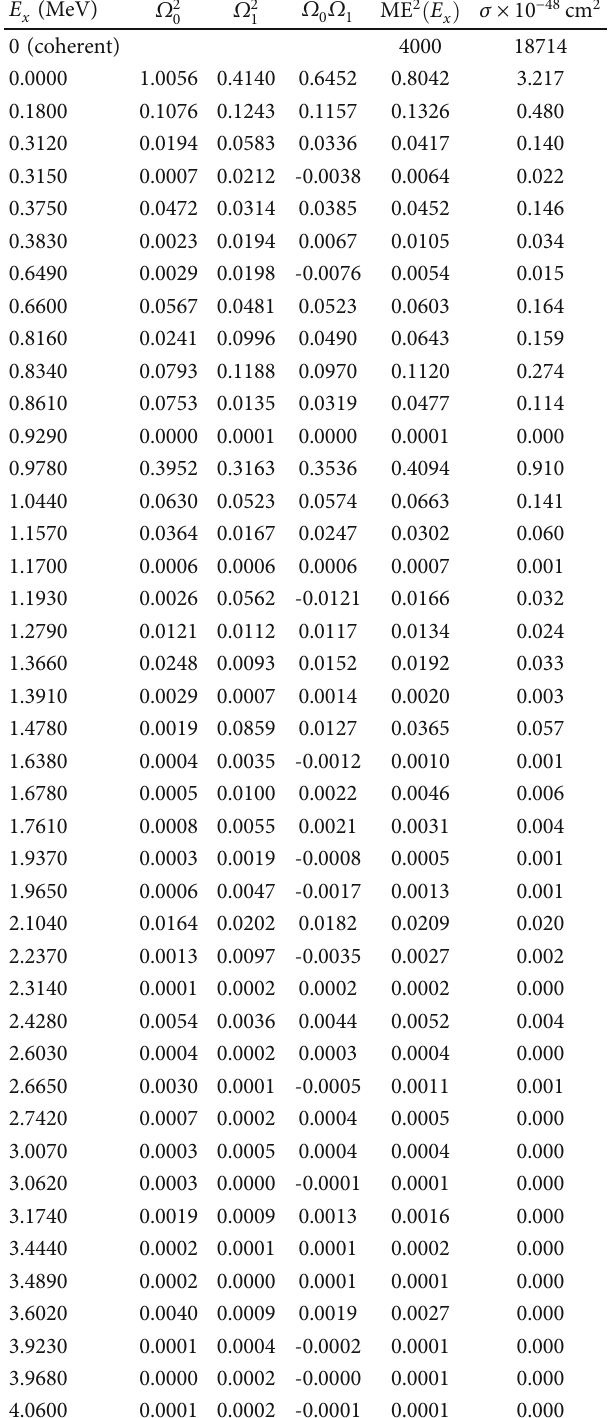
Table 1: Isoscalar and isovector spin-dependent matrix elements of 127 I from ground ( 5/2 + ) to excited states up to to the axion energy gs of 5.5MeV, which are relevant for axion photoproduction. We also Þ , including that include the total nuclear matrix elements ME 2 ð E x of the spin-independent matrix elements entering in the coherent ÞÞ 3 related to the / E mode, which contain the factor ð 1 − ð E x a photon energy, and the corresponding cross sections.